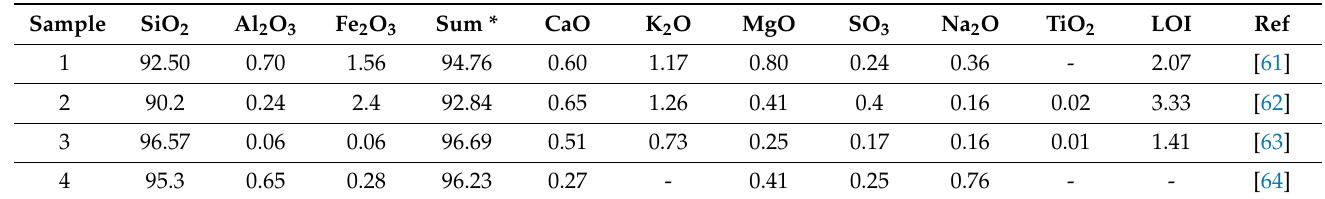
Table 2. Chemical composition of SF (Note: Sum * is the sum of pozzolanic oxides).